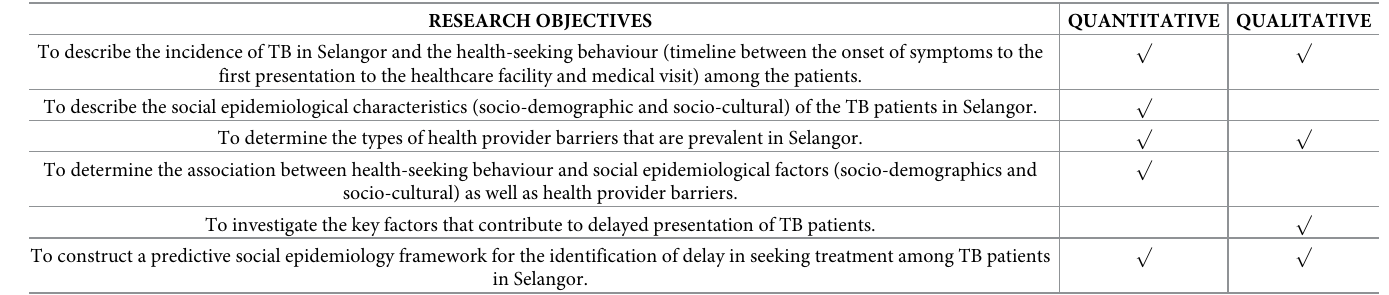
Table 1. Research